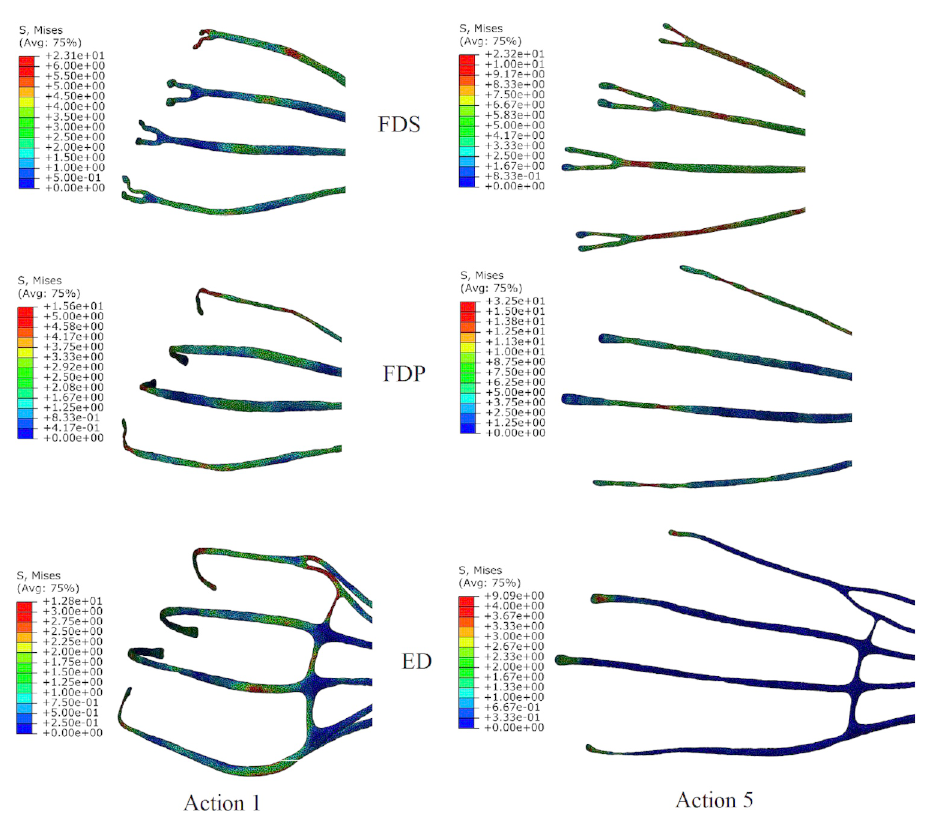
Fig 7. Stress clouds of each tendon under load conditions of actions 1 and